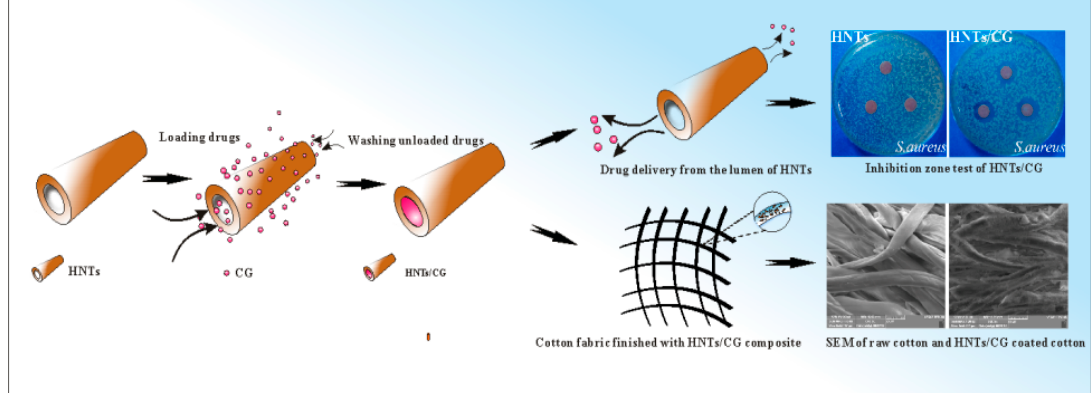
Figure 1. Illustration of the preparation of halloysite nanotubes (HNTs)/chlorhexidine gluconate (CG) composite, drug release from the lumen of HNTs, and the application on cotton fabric. SEM: scanning electron microscope. Adapted with permission from [4], Royal Society of Chemistry, 2017.